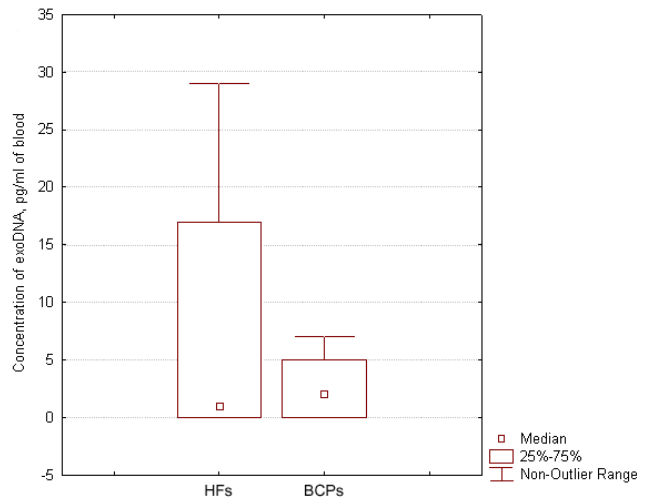
Figure 4. Exosomal DNA concentration in the blood of HFs and BCPs. Tukey box plots of exoDNA. Median exoDNA concentrations with 25–75% and non-outlier range bars are indicated.